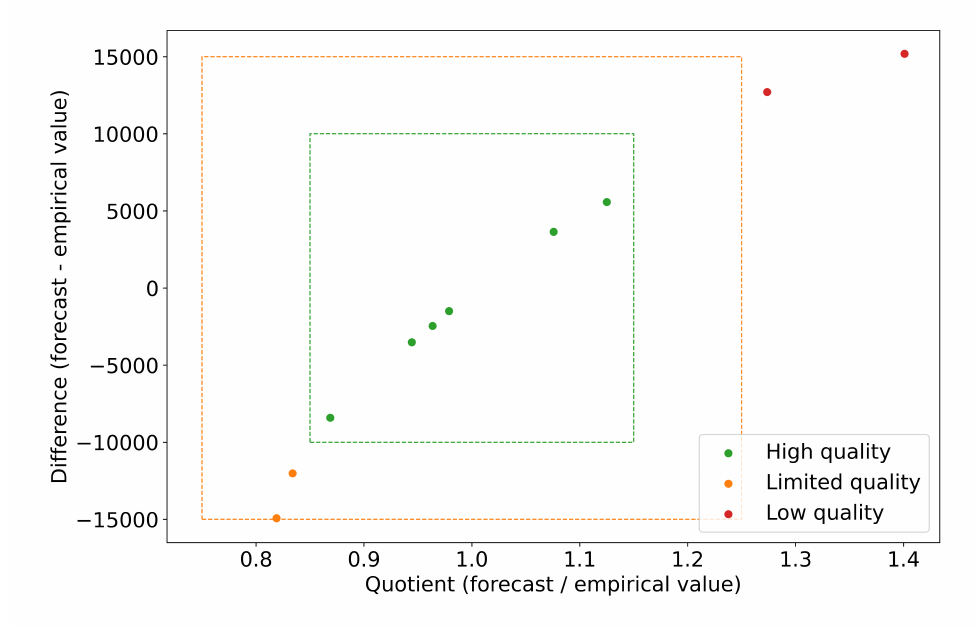
Figure 6. Rating of the forecasting quality of the multivariate UCM. The forecast quality of the model is mostly high. A limited forecast quality can be observed at the transition from summer to autumn (September/October) and a low quality in the winter months (January and